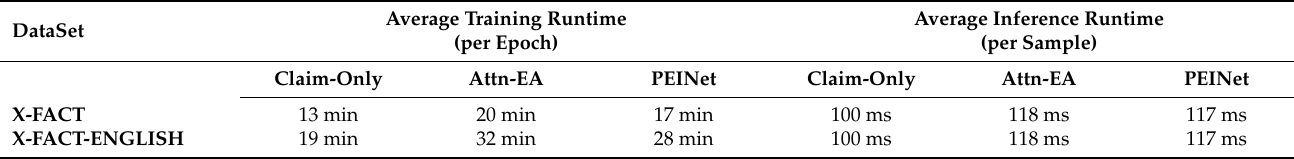
Table A2. The statistical results of the average training runtime in per epoch and the inference runtime in per sample. For short, minute is min, and millisecond is